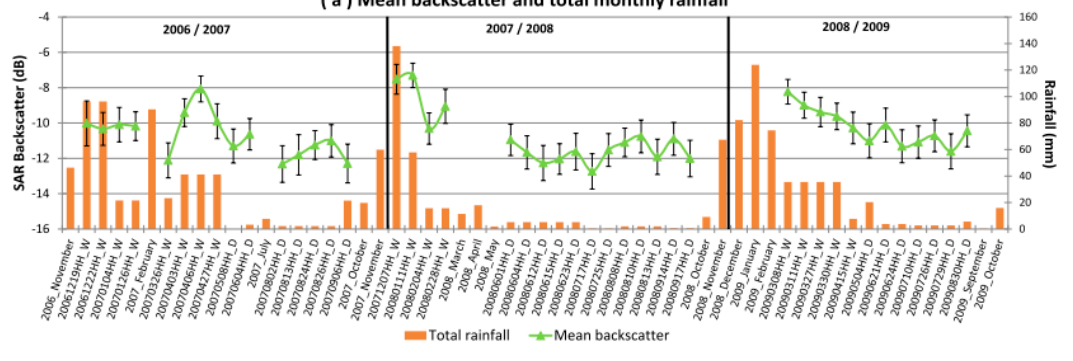
Figure 2. Cont. Figure 2.